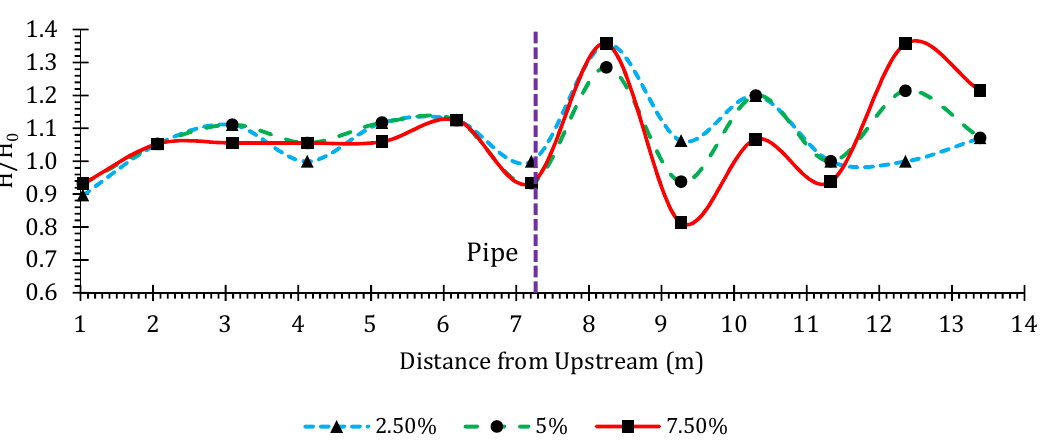
Figure A44. Water height ratios in a 45 ◦ junction for Fr = 3.27 in the narrow Figure A44. Water height ratios in a 45° junction for Fr = 3.27 in the narrow channel. Figure A44. Water height ratios in a 45° junction for Fr = 3.27 in the narrow channel. Figure A44. Water height ratios in a 45° junction for Fr = 3.27 in the narrow channel.